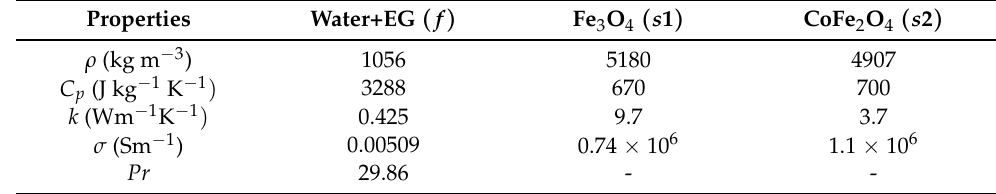
Table 1. Thermophysical properties of the fluid and solid materials in this study (Kumar et al. [21]). Properties